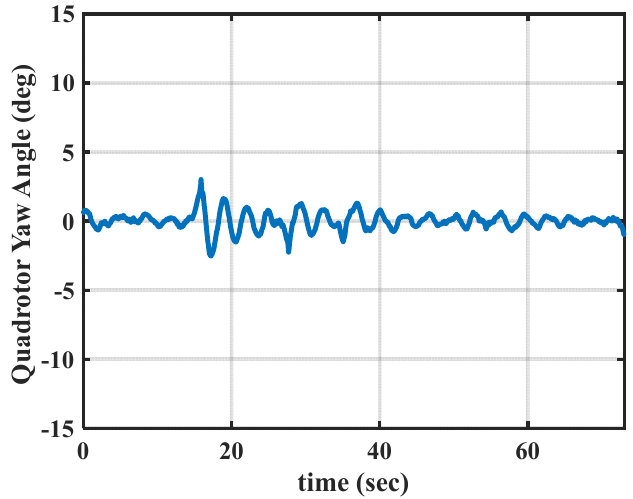
Figure 16. Quadcopter pitch angle.